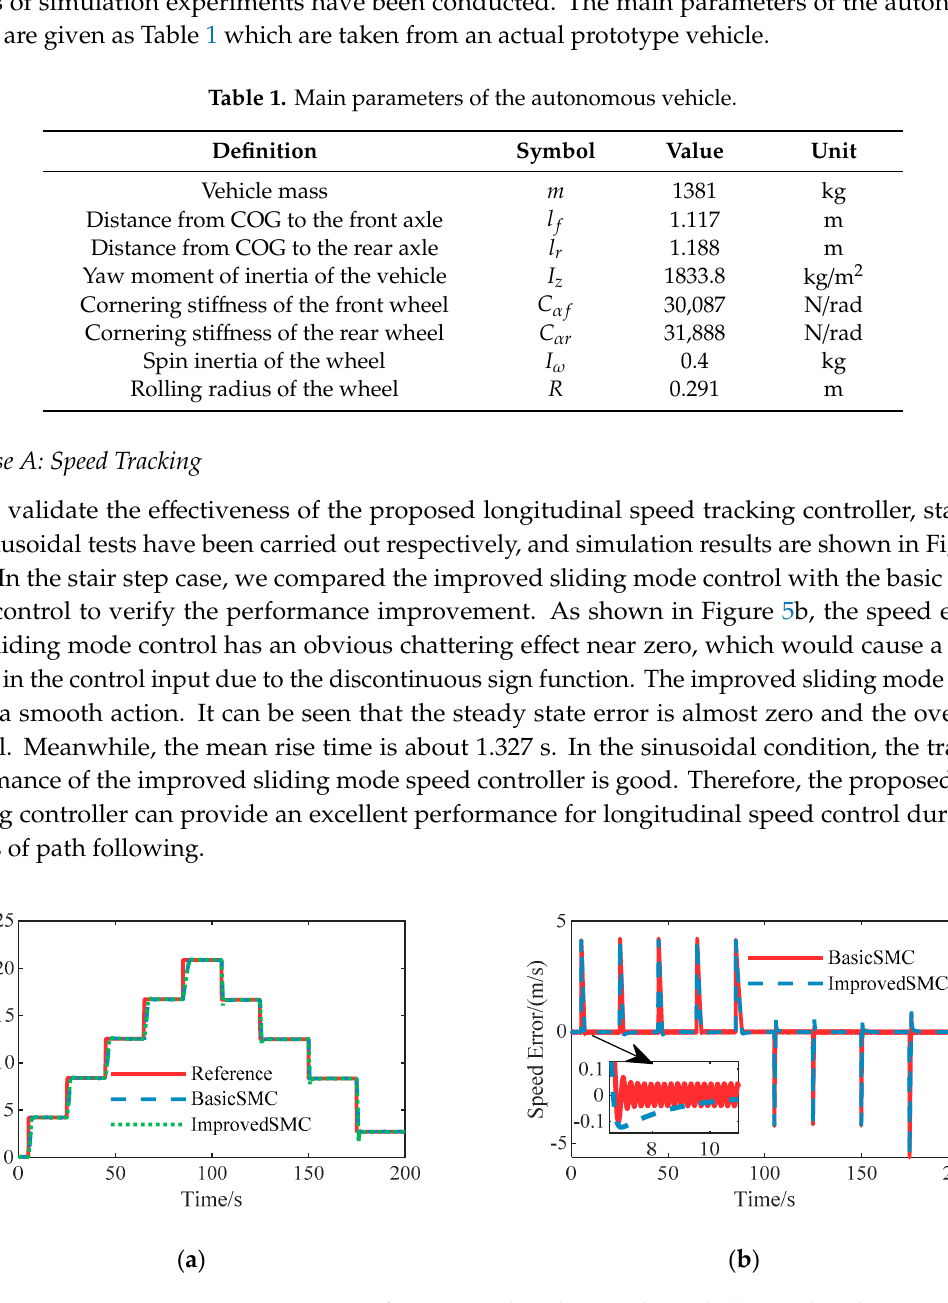
( b ) Figure 6. System responses to sinusoidal reference speed on the straight road: ( a ) Speed tracking results; ( b ) The resulting speed tracking error. 6.2. Case B: Skid Pad Test To illustrate the steady state characteristics of the proposed lateral controllers for autonomous vehicles, the skid pad test was chosen. As shown as Figure 7a, it consists of two circular paths that intersect at a tangent point. Meanwhile, it includes a point with discontinuous curvature where vehicles transition from one circle to another, which can provide insight into robustness to path curvature. Figure 7 demonstrates the responses of the designed lateral controllers. It can be seen that the steady state lateral error of the nonlinear ADRC controller is nearly zero and the steady state lateral error of LPV-MPC is about 0.0254 m, while the pure pursuit method-based controller suffers from higher steady state error. Besides, both the nonlinear ADRC and PPM controllers suffer from higher overshoot, in this case due to discontinuous curvature at the tangent point.